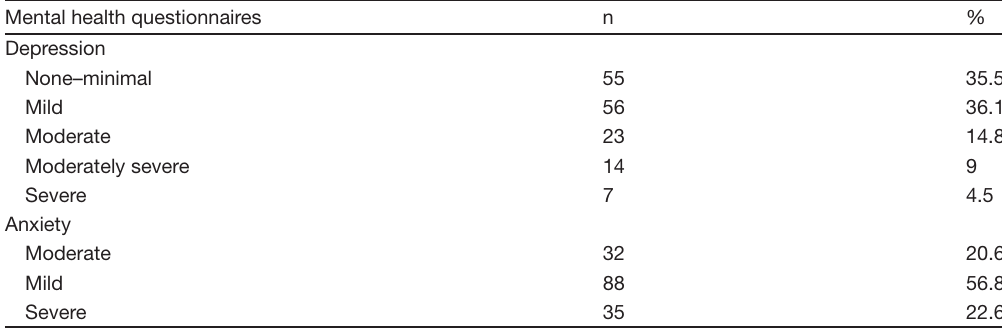
Table 3. Overview of the mental health questionnaires split into the threshold categories for clinical symptoms Mental health questionnaires